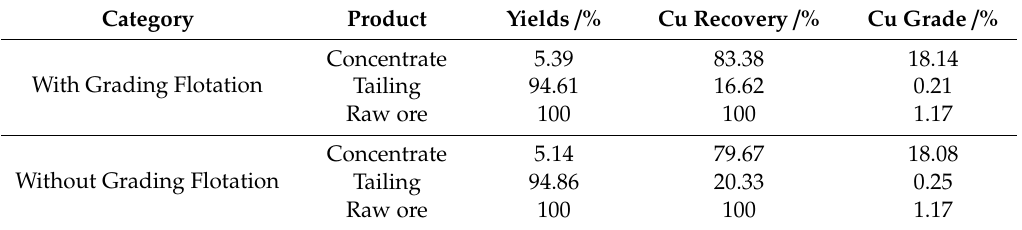
Table 6. Flotation grade and recovery of malachite with or without grading flotation